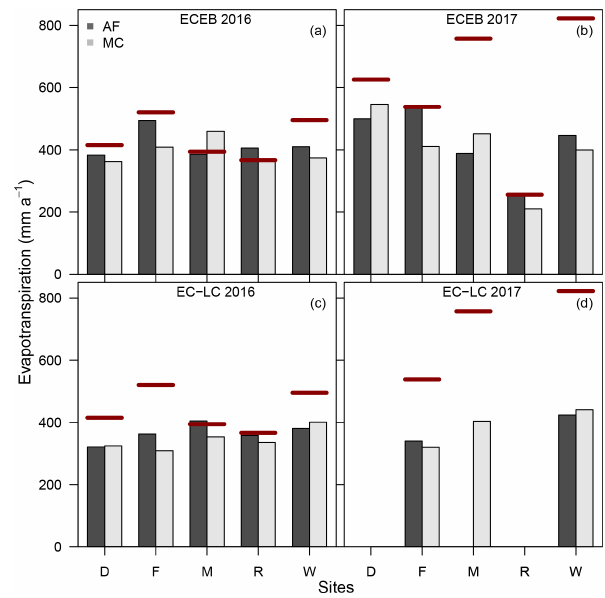
Figure 10. Annual sums of ET ECEB in 2016 (a) and 2017 (b) and ET EC-LC in 2016 (c) and 2017 (d) for Dornburg (D), Forst (F), Mariensee (M), Reiffenhausen (R), and Wendhausen (W). The red solid lines correspond to the annual sum of precipitation from the monoculture system of the respective site. The annual sums of evap- otranspiration at Reiffenhausen AF and Reiffenhausen MC in 2017 contain only data from 1 January to 9 July 2017 due to station fail- ure. Annual sums of ET EC-LC for Dornburg AF and MC, Mariensee AF, and Reiffenhausen AF and MC in 2017 are missing due to in- strument